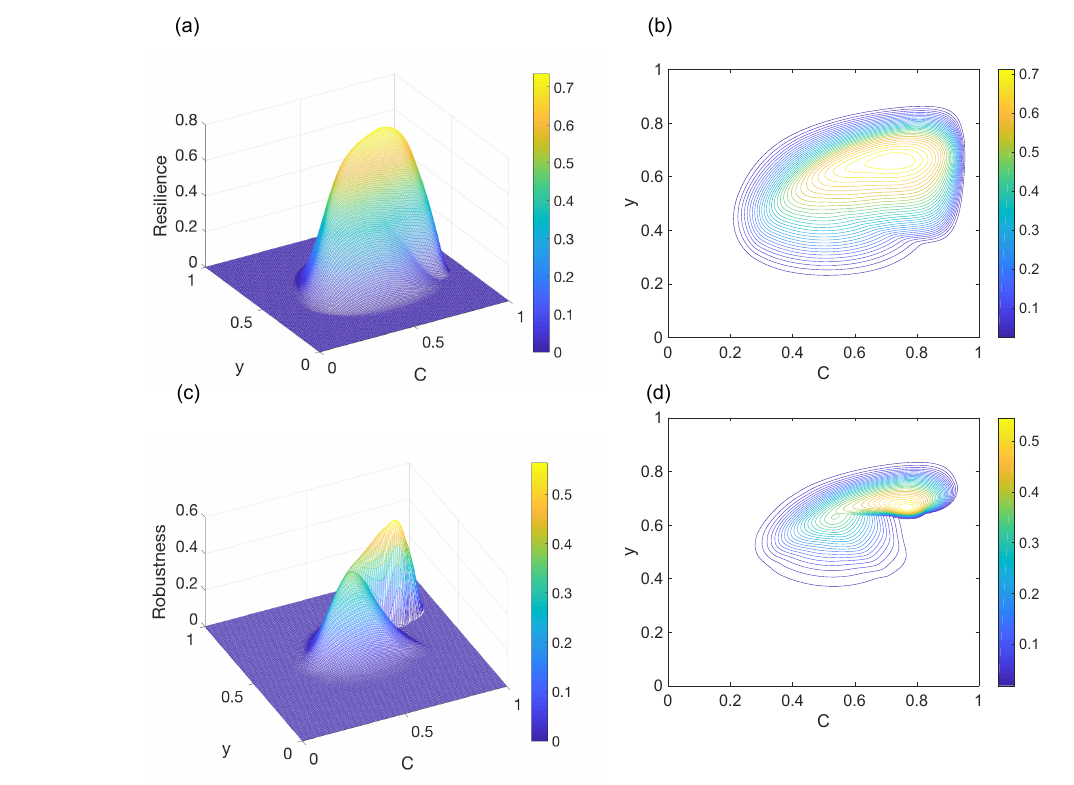
, and the below-mean mean of R system , µ R<µ , over the entire decision space. (a) Surface of the resilience Figure 3. The mean, µ R system metric, µ R ; (b) Contours of µ R ; (c) Surface of the robustness, the below-mean mean ( µ R<µ ); (d) Contours of µ R<µ . system system